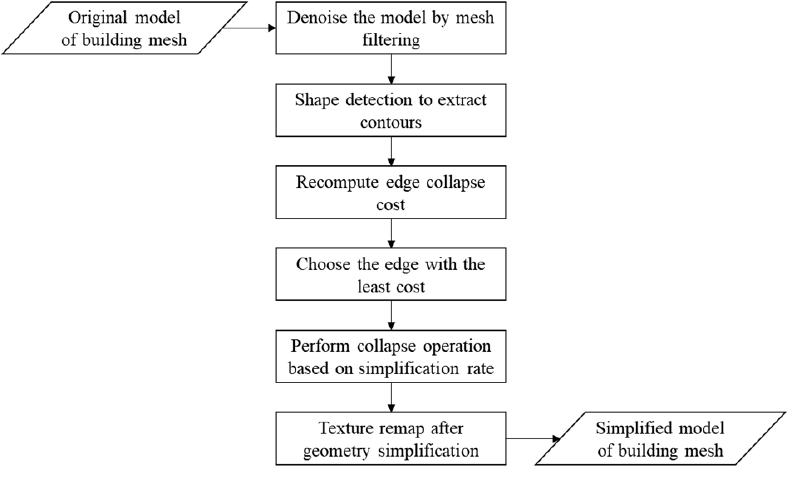
Figure 1. Pipeline of the proposed